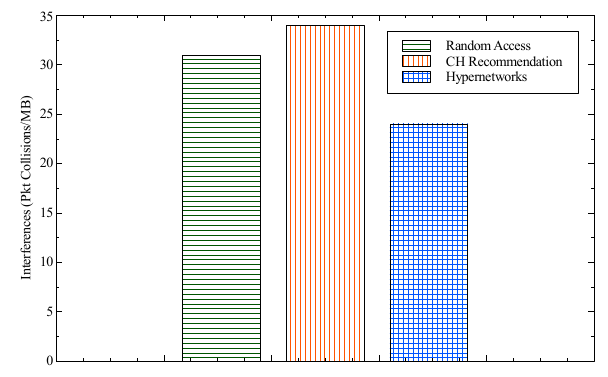
Figure 8. Collision instances with PU